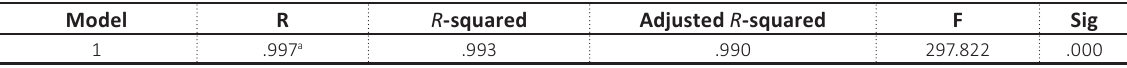
Table 1. Multiple regression results on the combined impacts of TW, perceived TS, and JI on OP Model